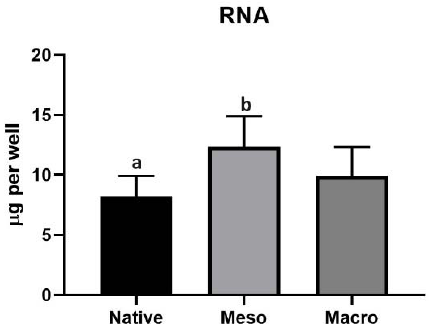
Figure 4. Total amount of RNA isolated from differentiating hiPSCs after 14 days. The different superscripts (a/b) express significant differences ( p ≤ 0.05) between the number of differentiating cells on the native and meso-porous